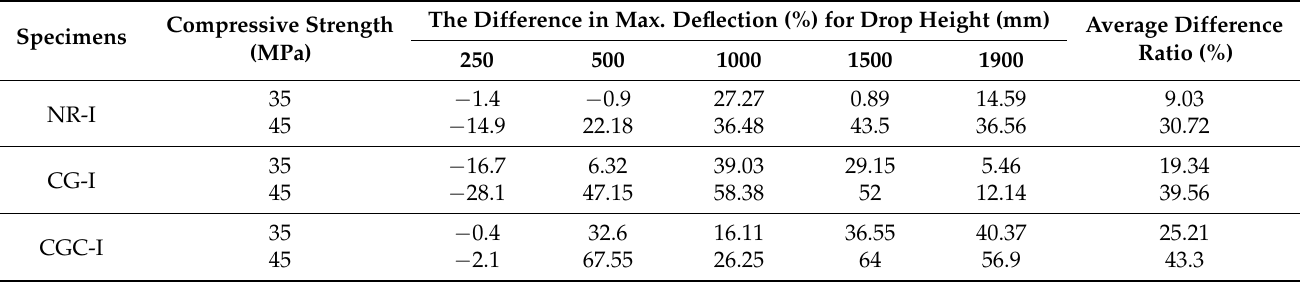
Table 12. Summary of the concrete compressive strength effects on the